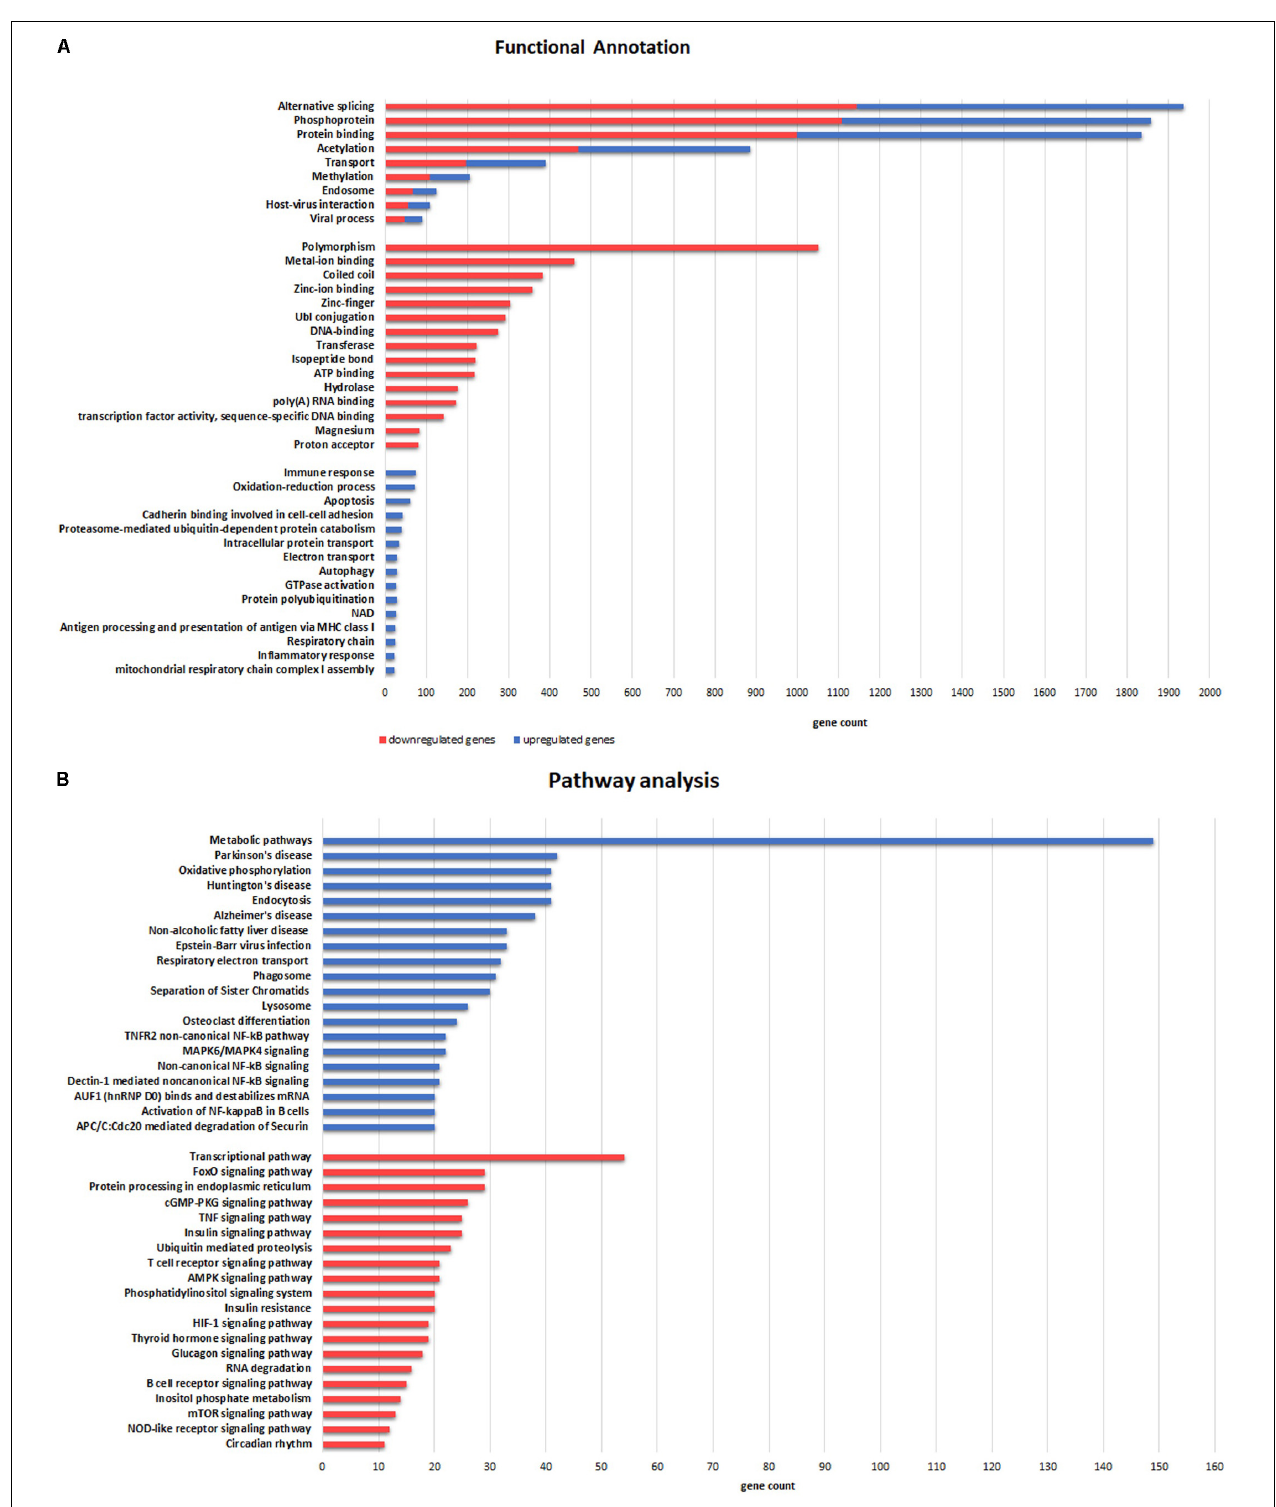
FIGURE 5 | Functional categories (A) and Pathway (B) enrichment analyses of DE genes. (A) Categories enriched in both upregulated ( blue ) and downregulated ( red ) genes are illustrated in the upper part. The more representative categories enriched in downregulated genes are illustrated in the middle section. Categories in the lower part are enriched in upregulated genes. (B) Pathways enriched in upregulated ( blue ) and downregulated ( red ) genes are illustrated in the upper and lower part, respectively. The X-axis represents gene counts involved in each functional category and pathway.